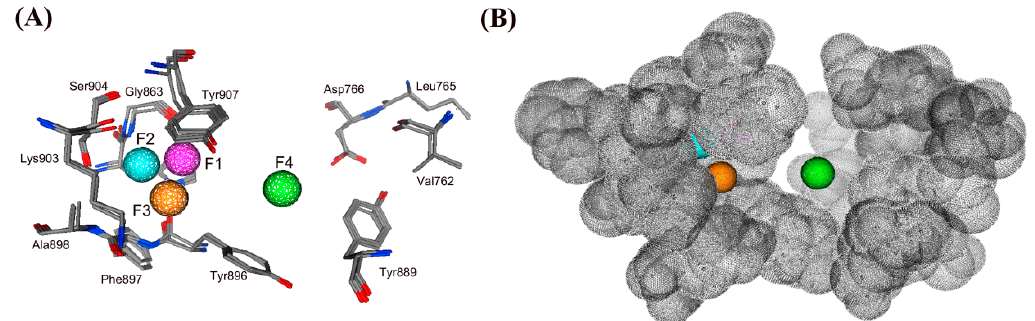
Figure 1. ( A ) The generated pharmacophore model in the binding site of PARP-1 (PDB ID: 6I8M). Pharmacophore features are color-coded: purple, one hydrogen bond donor feature (F1: Don); cyan, one hydrogen bond acceptor feature (F2: Acc); orange, one aromatic feature (F3: Aro); green, one hydrophobic feature (F4: Hyd). Active site residues (dark gray) are shown in line form. Residues are annotated with their three-letter amino acid code. ( B ) A steric constriction (dark gray) was added to the pharmacophore model.